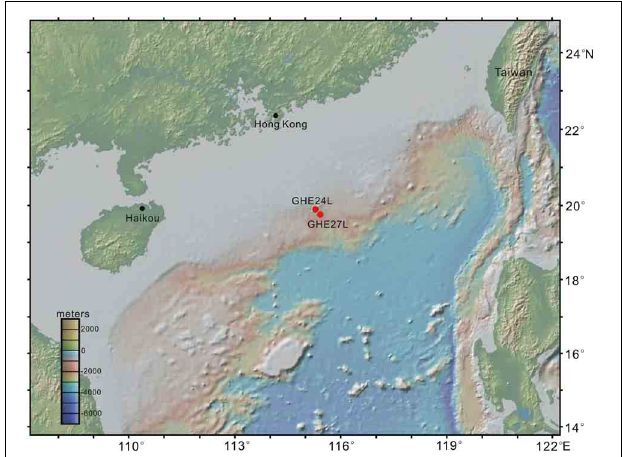
FIGURE 1 | Digital elevation map of the studying area (http://www.geomapapp.org; Ryan et al., 2009) showing the locations of Cores GHE24L and GHE27L on the northern slope of the South China